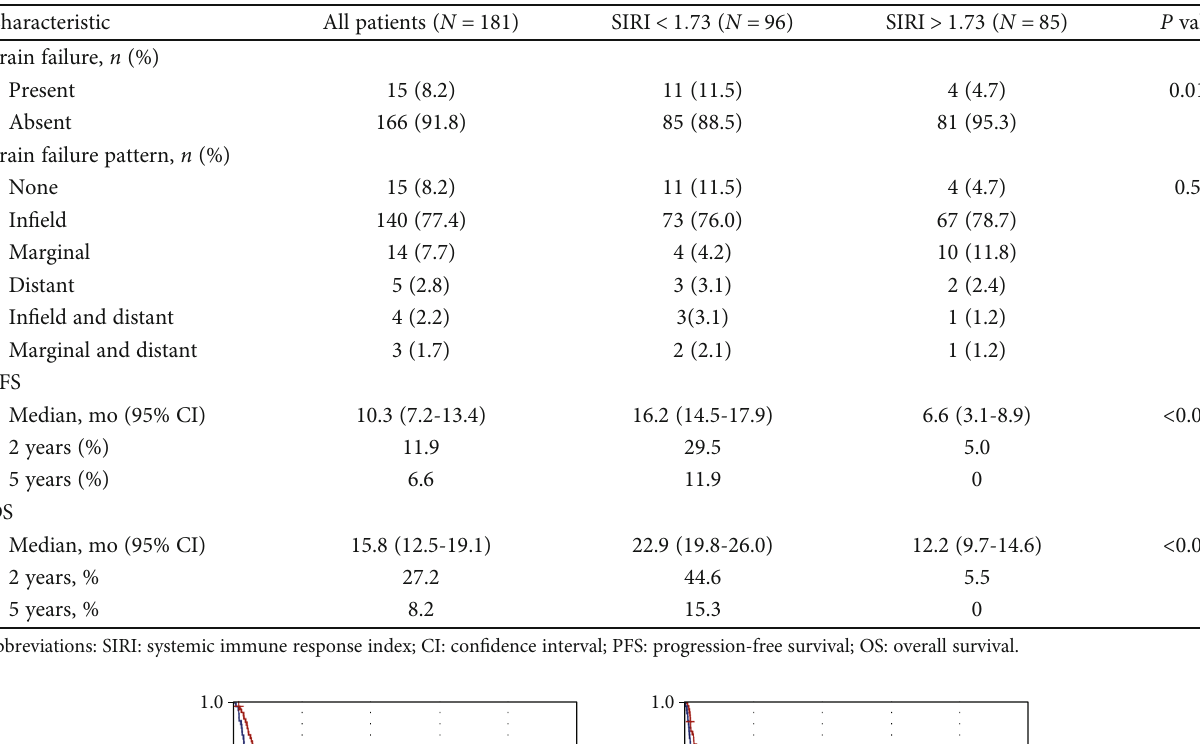
Table 3: Brain failure and survival outcomes per SIRI group.